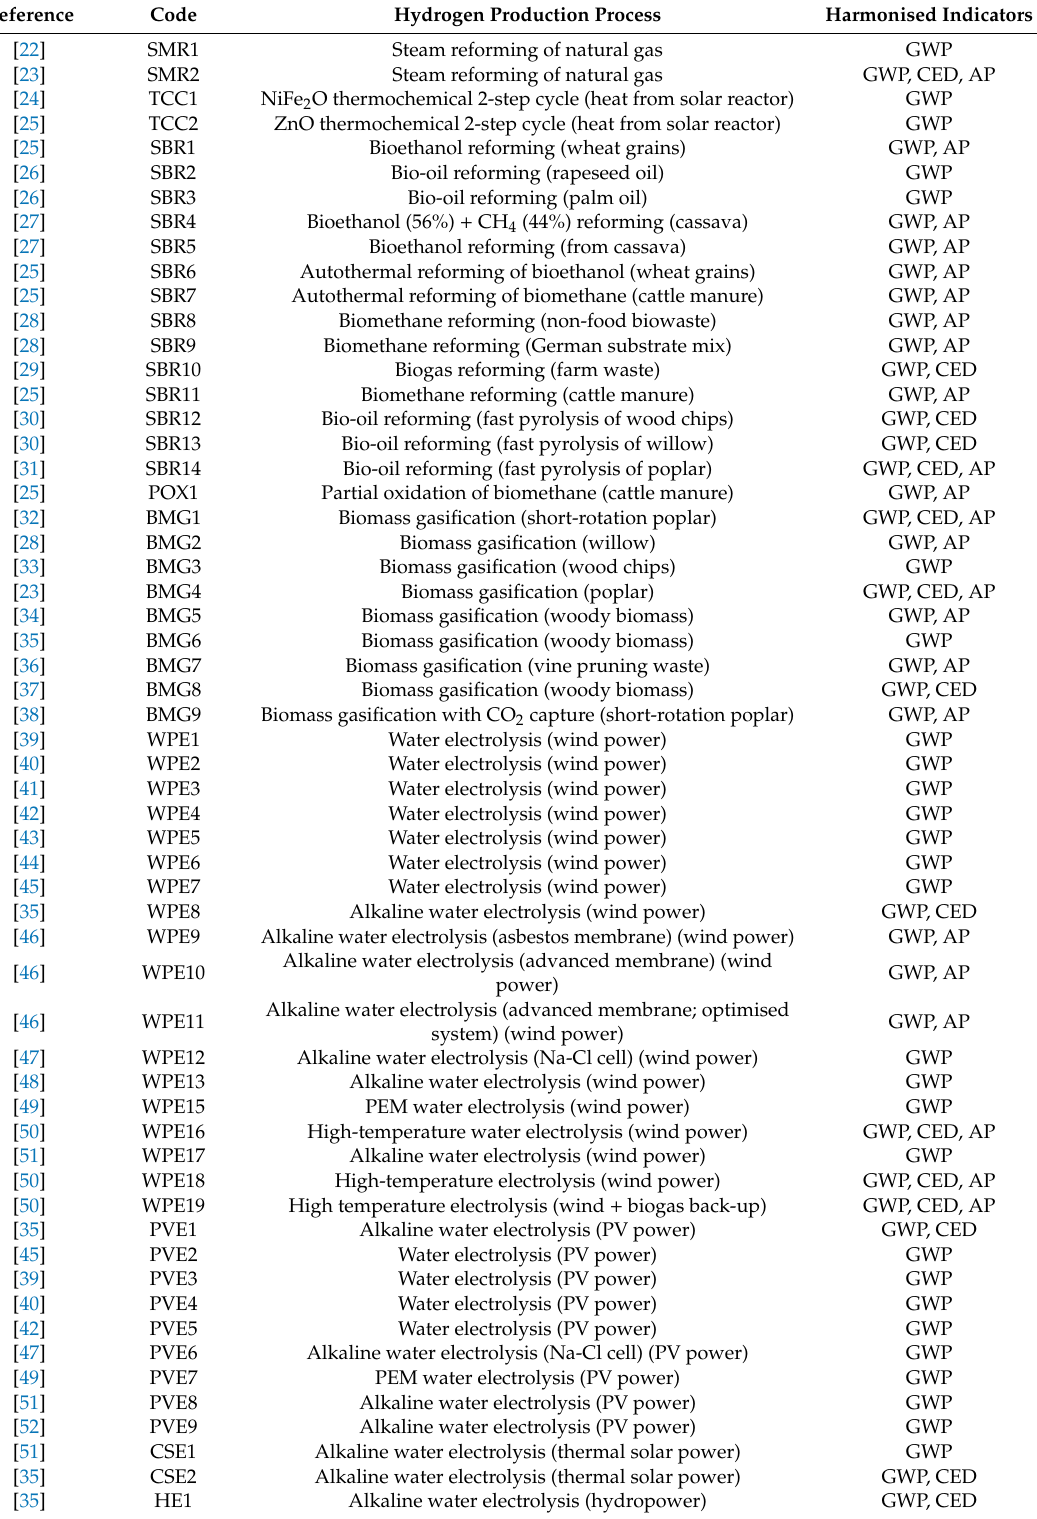
Table A1. Case studies in the libraries of harmonised carbon [12], energy [13], and acidification [14]